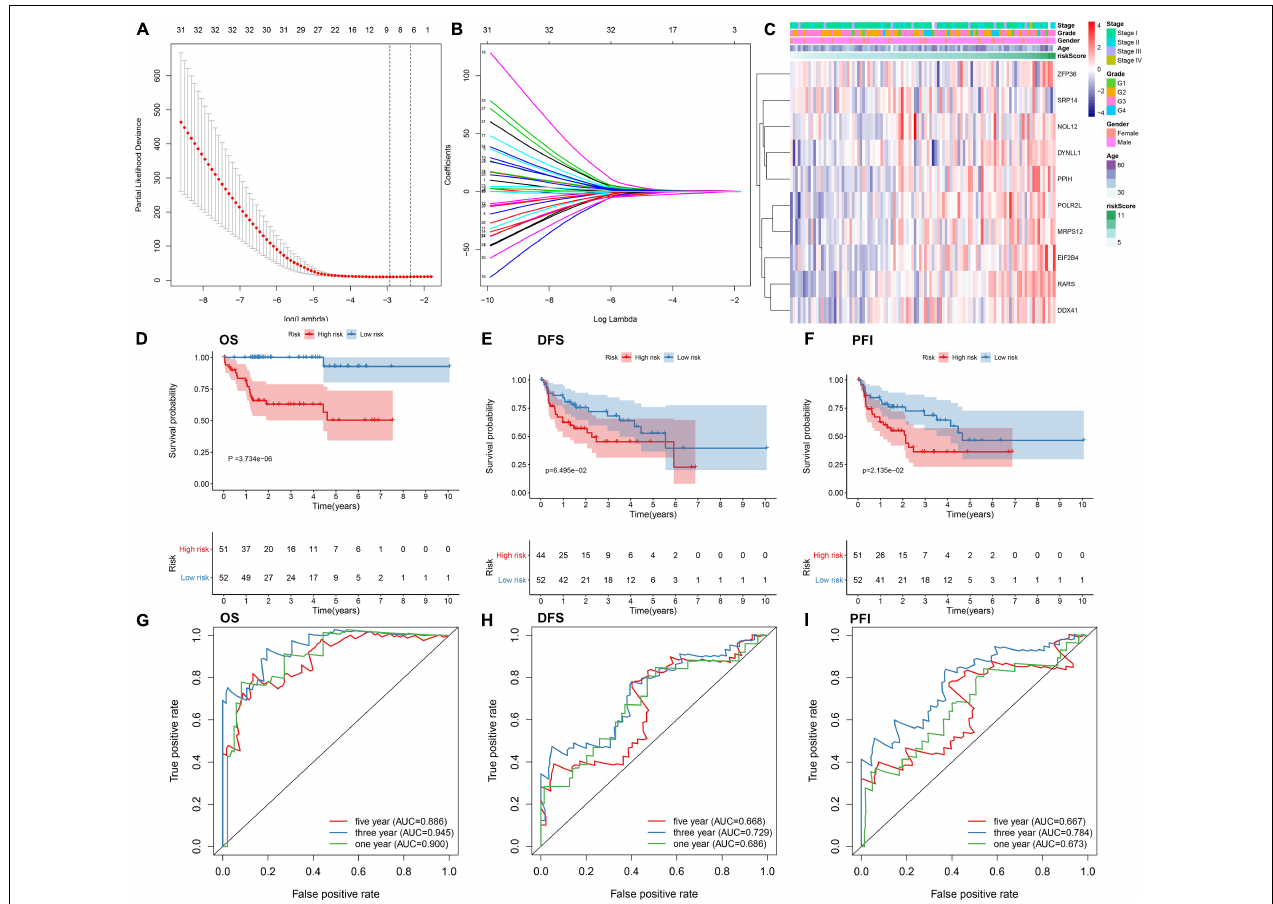
FIGURE 2 | Establishing an RBP prognostic model for HBV-related HCC patients in the TCGA dataset. (A) Relationships of λ and partial likelihood deviance. The vertical slash represents the optimal λ value. (B) LASSO regression coefficients of RBPs in this model. (C) Heatmap for the correlations between expression values of RBPs and clinical features. Kaplan-Meier curves of (D) OS, (E) DFS and (F) PFI between high- and low-risk patients. The ROCs of (G) OS, (H) DFS, and (I) PFI based on the risk score.